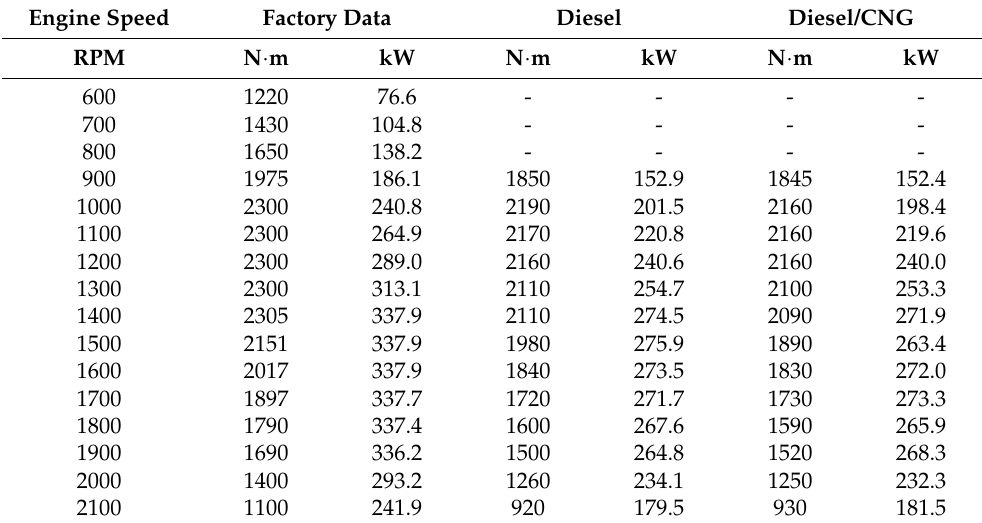
Table 2. Comparison of the values of the torque and the useful power used in the traction calculations of a set of vehicles.